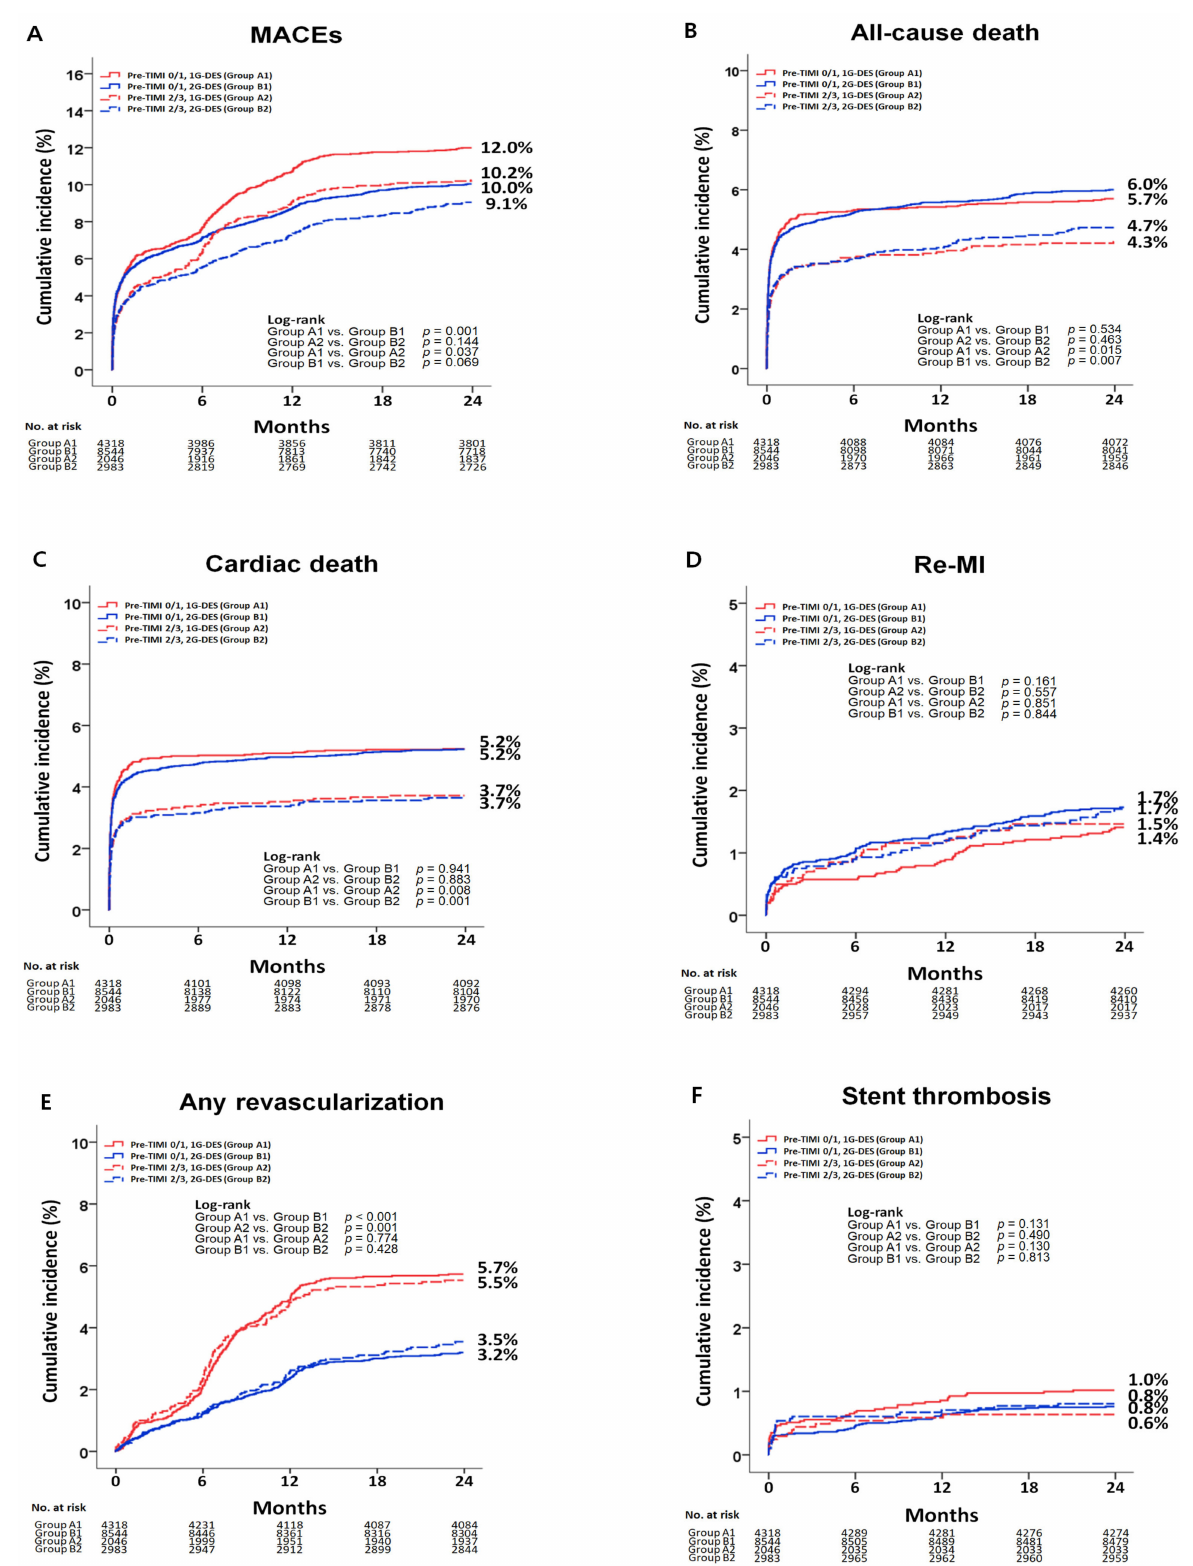
Figure 2. Kaplan–Meier analysis for the MACEs ( A ), all-cause death ( B ), cardiac death ( C ), Re-MI ( D ), any repeat revascular- ization ( E ), and stent thrombosis ( F ) at 2 years. MACEs, major adverse cardiac events; Re-MI, recurrent myocardial infarction; Pre-TIMI, pre-percutaneous coronary intervention thrombolysis in myocardial infarction flow grade; 1G, first-generation; 2G, second-generation; DES, drug-eluting